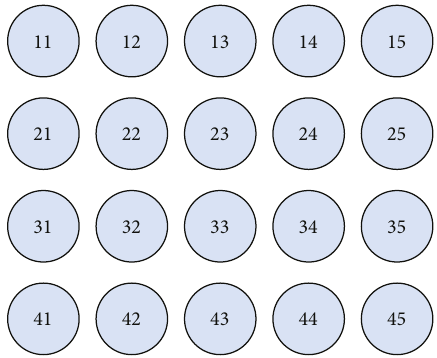
Figure 1: Periodic structure with a fi nite size of 4 × 5